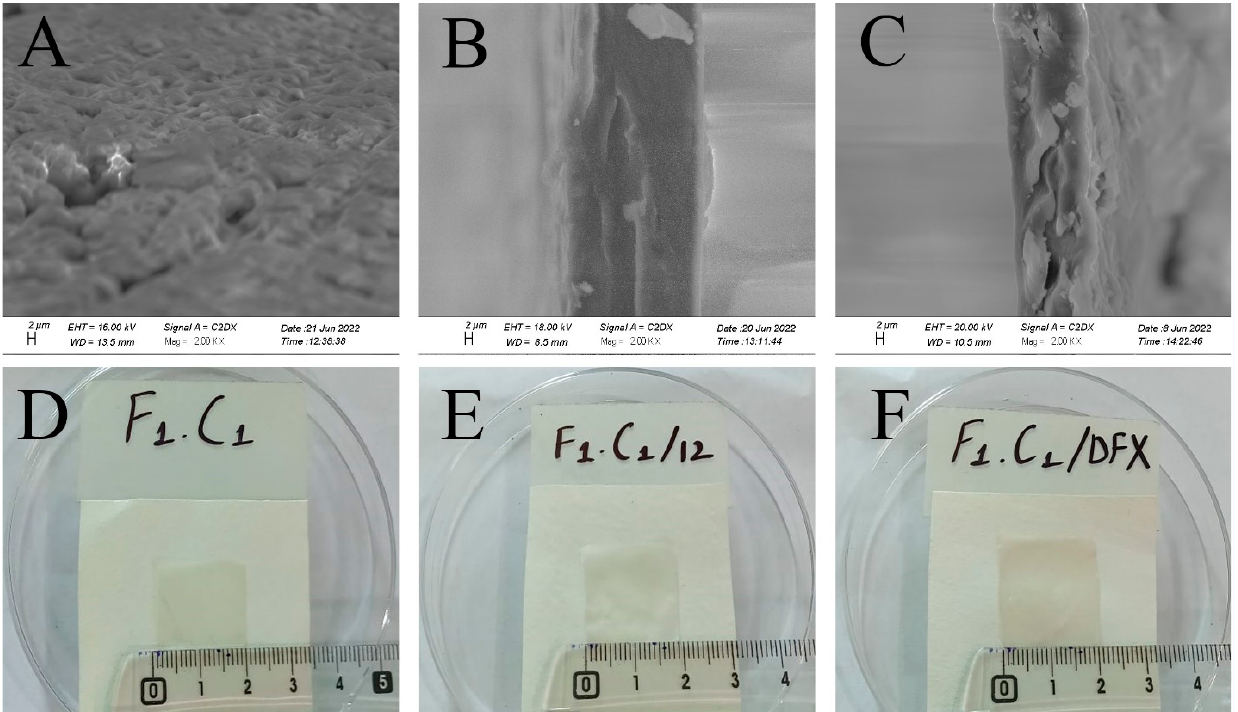
Figure 3. Cross-sectional SEM images of ( A ) F 1 C 1 , ( B ) (F 1 C 1 .12), ( C ) (F 1 C 1 .DFX), and photographs of the respective composites ( D – F ), respectively.